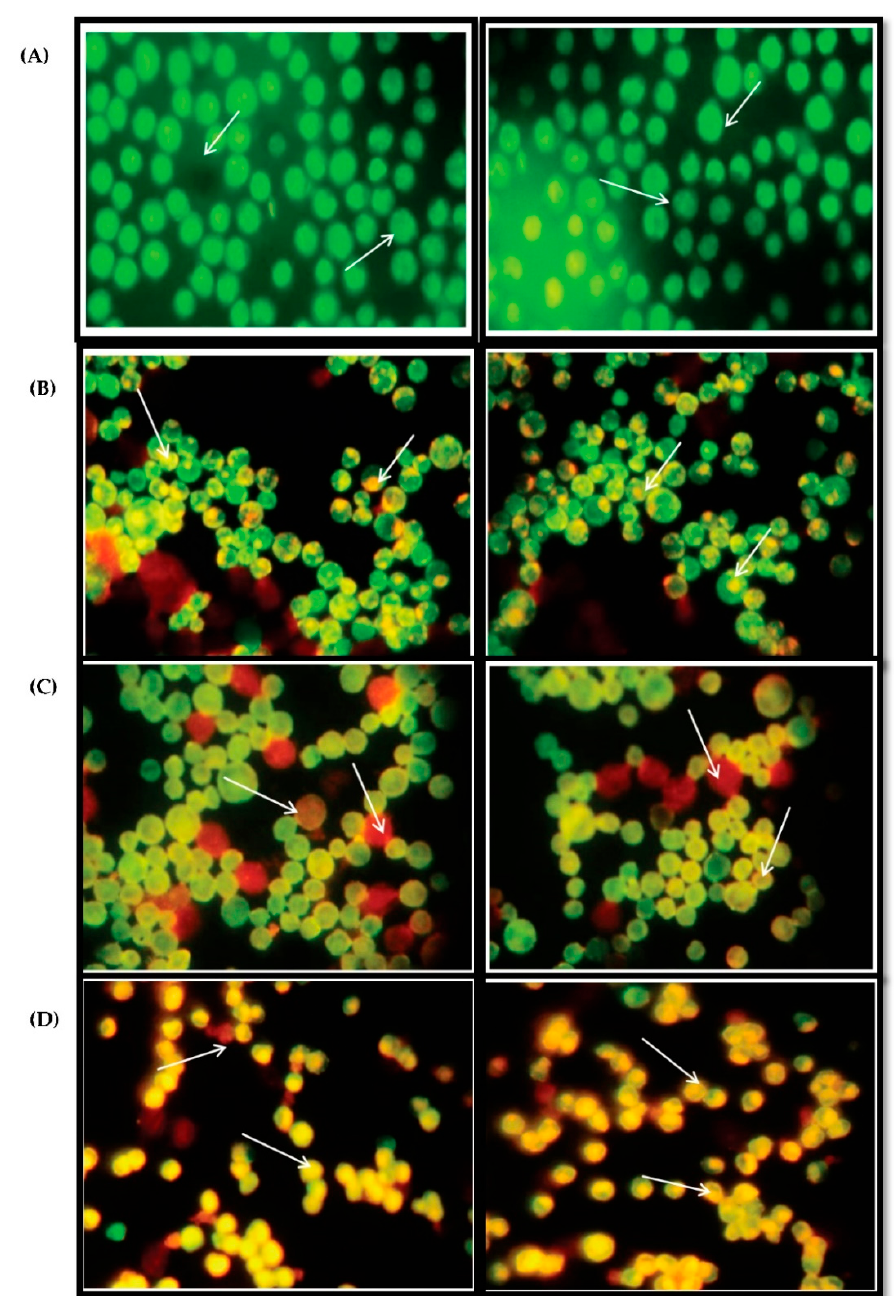
Figure 8. ( A ) controlHepG2 cells; ( B ) W. Somnifera 80 μ g/mL; ( C ) W. somnifera 160 μ g/mL; ( D ) Standard doxorubicin.